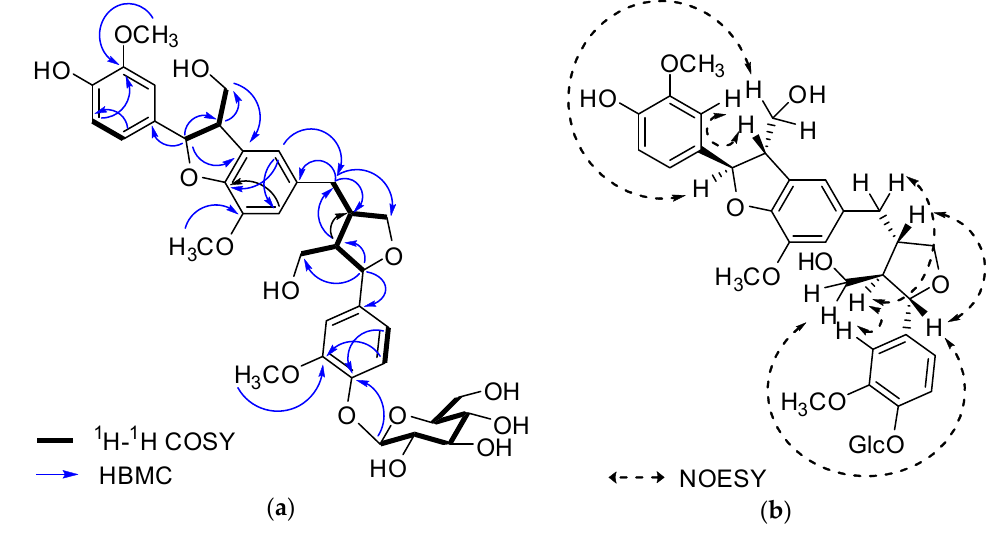
Figure 2. Key 1 H- 1 H COSY, HMBC ( a ) and NOESY ( b ) correlations of 1 .